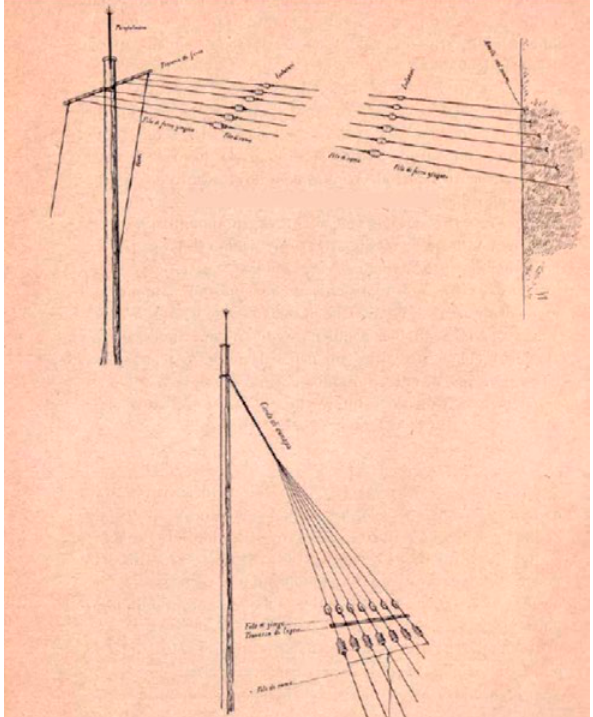
Figure 2. Drawing of the second (upper) and third (lower) radio equipment related to the aerial.